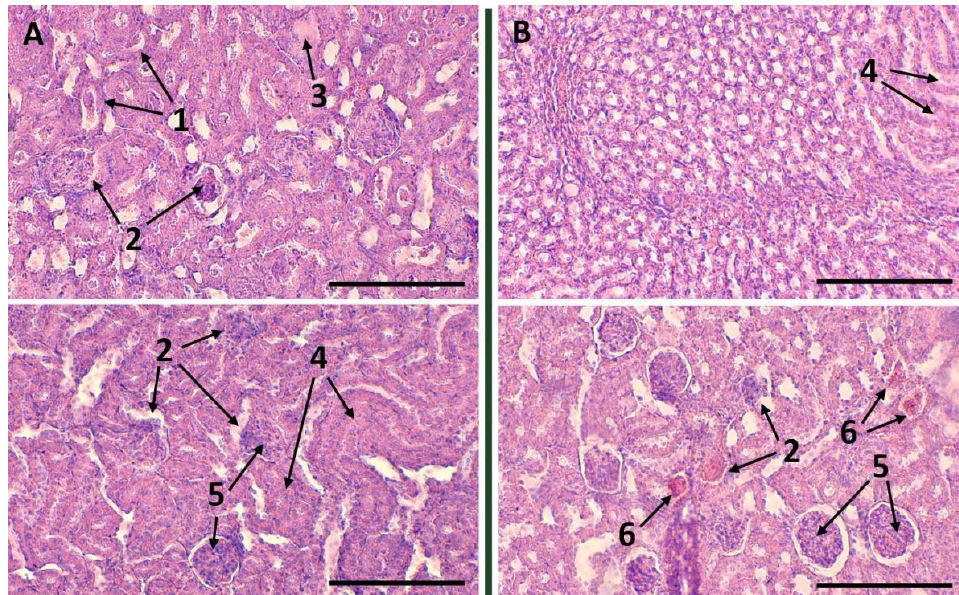
Figure 6. Renal tissue 7 d after therapy of acute glomerulonephritis using intra-arterial injection etanercept in free ( A ) and encapsulated ( B ) form: fibrin clots in the tubules’ lumen (1); degeneration of glomerular capillaries, collapse of the Bowman’s capsule (2); small foci of the renal parenchyma sclerosis (3); local accumulation of immune cells in the parenchyma (infiltrate) (3); epithelial dystrophy or tubular lumen occlusion (4); multicellularity and glomerular edema—a sign of inflammation, narrowing of the Bowman’s capsule lumen (5); vascular plethora (6). The thickness of the histological samples is 5 μm; dyes: hematoxylin and eosin. The scale bar is 200 μm.